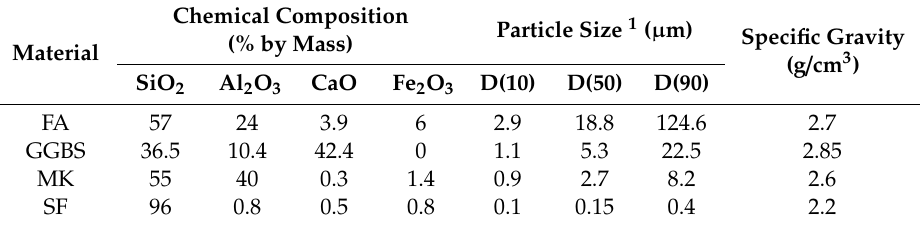
Table 2. Chemical composition, particle sizes, and specific gravity of geopolymer powders.